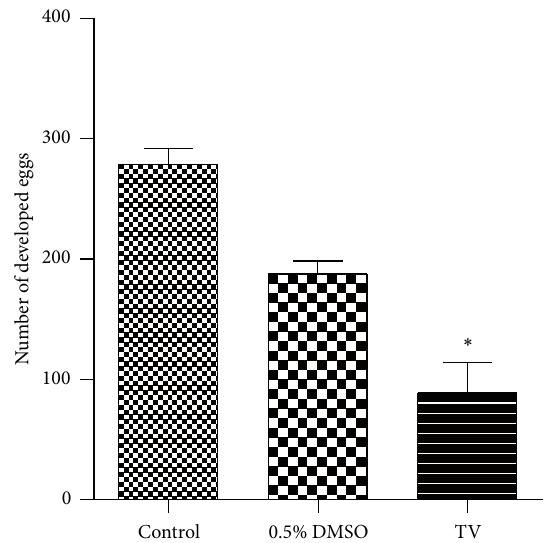
Figure 2: In vitro effect of the crude hydroalcoholic extract of T. vulgare (TV) on the viability of the S. mansoni adult worms. Pairs of adult worms were treated with TV at 200 𝜇 g/mL during 120 h and the viability was measured by MTT assay at 550 nm. RPMI 1640 medium and 0.5% DMSO in RPMI 1640 medium were used as negativecontrolgroups.Heat-killedwormsat56 ∘ C(dead)wereused as positive control group. The viability was expressed as mean of the absorbance values from three experiments. ∗ Significantly different from control ( 𝑃 < 0.05 ); § significantly different from dead group ( 𝑃 < 0.05 ).